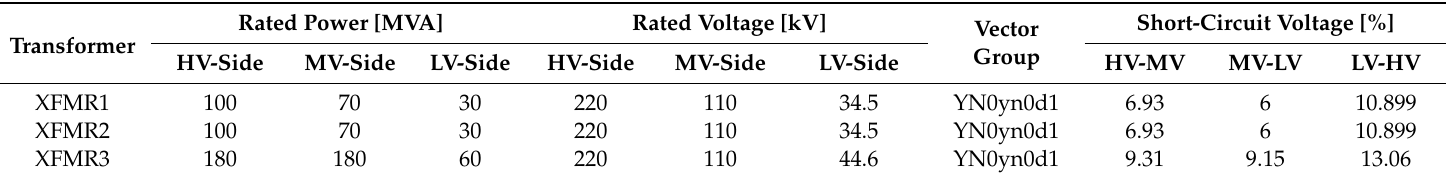
Table A2. Electrical parameters for the network transformers used in the STS.